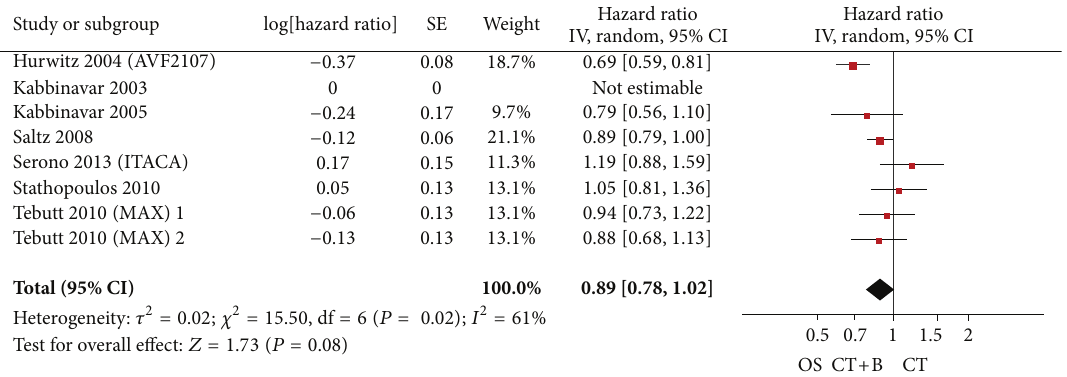
Figure 2: Randomized effect model on HR of OS in first-line chemotherapy. The pooled HR of OS in first-line chemotherapy is symbolized by a solid diamond at the bottom of the forest plot and the width of which represents the 95%